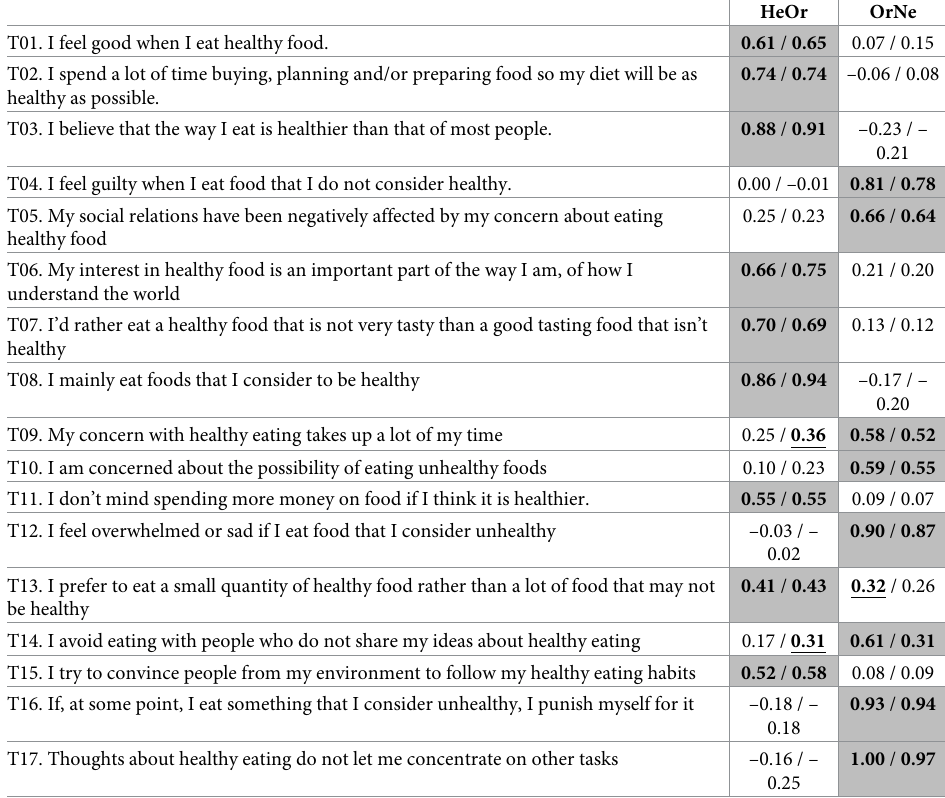
Table 2. Item loadings for the Teruel Orthorexia Scale.